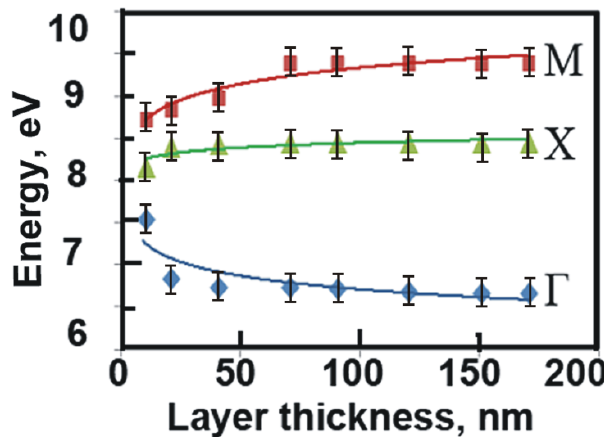
Figure 5. Energy positions of HREELS intensive peaks characterizing interband transitions in Г, X, and M symmetry directions in the Brillouin zone of Al 2 O 3 layers.